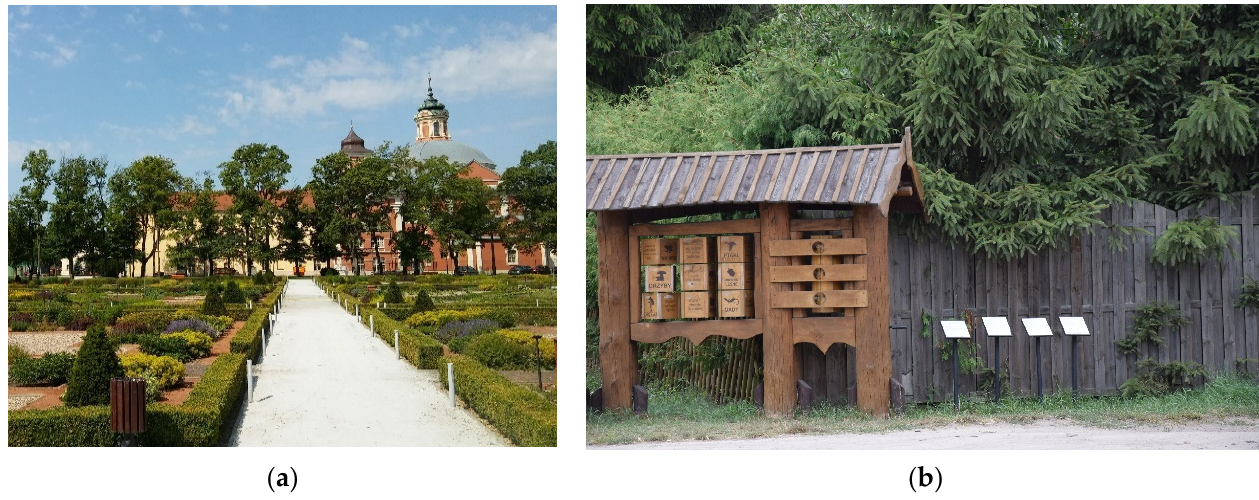
Figure 3. Clear path layout, ( a ) Owi ń ska, and ( b ) facilities tailored to the needs of the blind, Chorz ę powo (fot. A. Zajadacz).